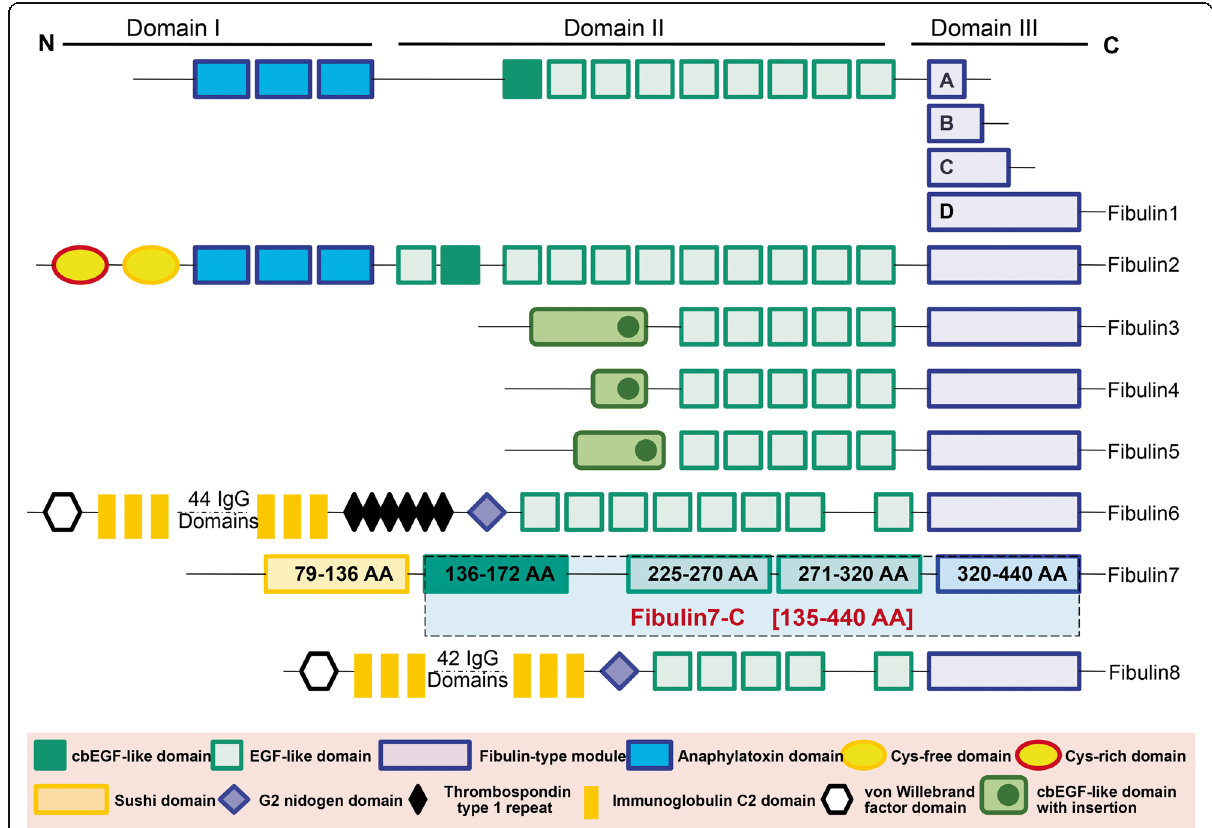
Fig. 1 Domain structure of eight members of the fibulin family of proteins. The proteins are composed of three domains. Domain-I or the N- terminal domain varies among different fibulins, domain-II consists of a variable number of tandemly arranged epidermal growth factor (EGF)-like modules or calcium-binding EGF (cbEGF)-like modules while, domain-III or the C-terminal or fibulin-type module is unique to all fibulins. Fbln7 has an additional sushi domain on the N-terminal, and the shaded area in the C terminus shows the Fbln7-C